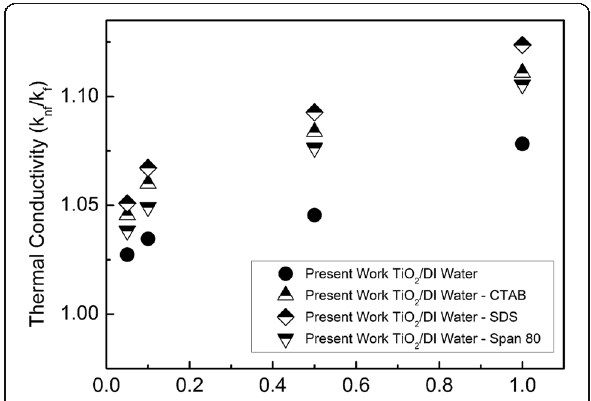
Fig. 4 Effect of different surfactants on the thermal conductivity of TiO 2 – water nanofluids [65]. Reproduced with permission from